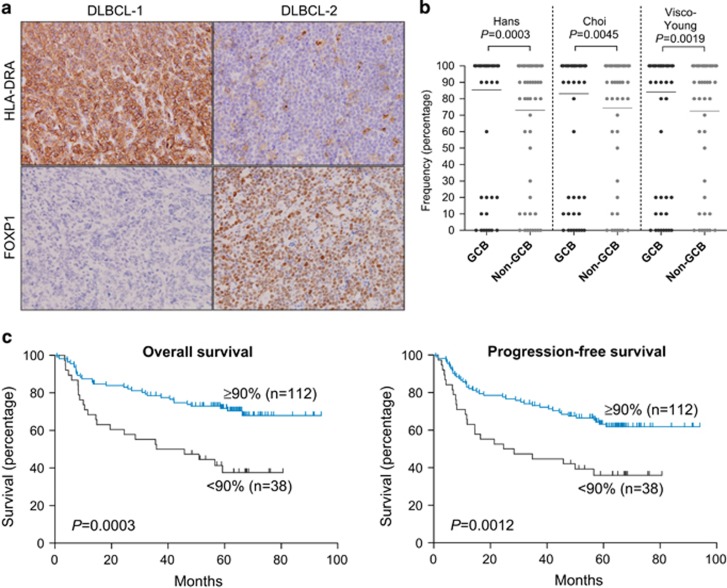
HLA-DRA expression and its relationship with FOXP1, COO and clinical outcome in primary DLBCL patients. (a) Representative DLBCL cases with inverse FOXP1 and HLA-DRA expression patterns by immunohistochemical labeling and photographed at × 200 magnification. DLBCL-1 biopsy was scored 100% for HLA-DRA positivity and 0% for FOXP1-positive cells. DLBCL-2 biopsy was scored 0% and 90% for HLA-DRA and FOXP1 labeling, respectively. (b) Frequency of HLA-DRA positivity in GCB- and non-GCB-DLBCL cases is significantly different (P<0.05), as classified by Hans, Choi and Visco–Young algorithms. (c) Kaplan–Meier curves of OS (left panel) and PFS (right panel) in high (⩾90%) or low (<90%) HLA-DRA expressing groups of DLBCL patients (n=150) showed worse outcome for patients exhibiting <90% HLA-DRA positivity.